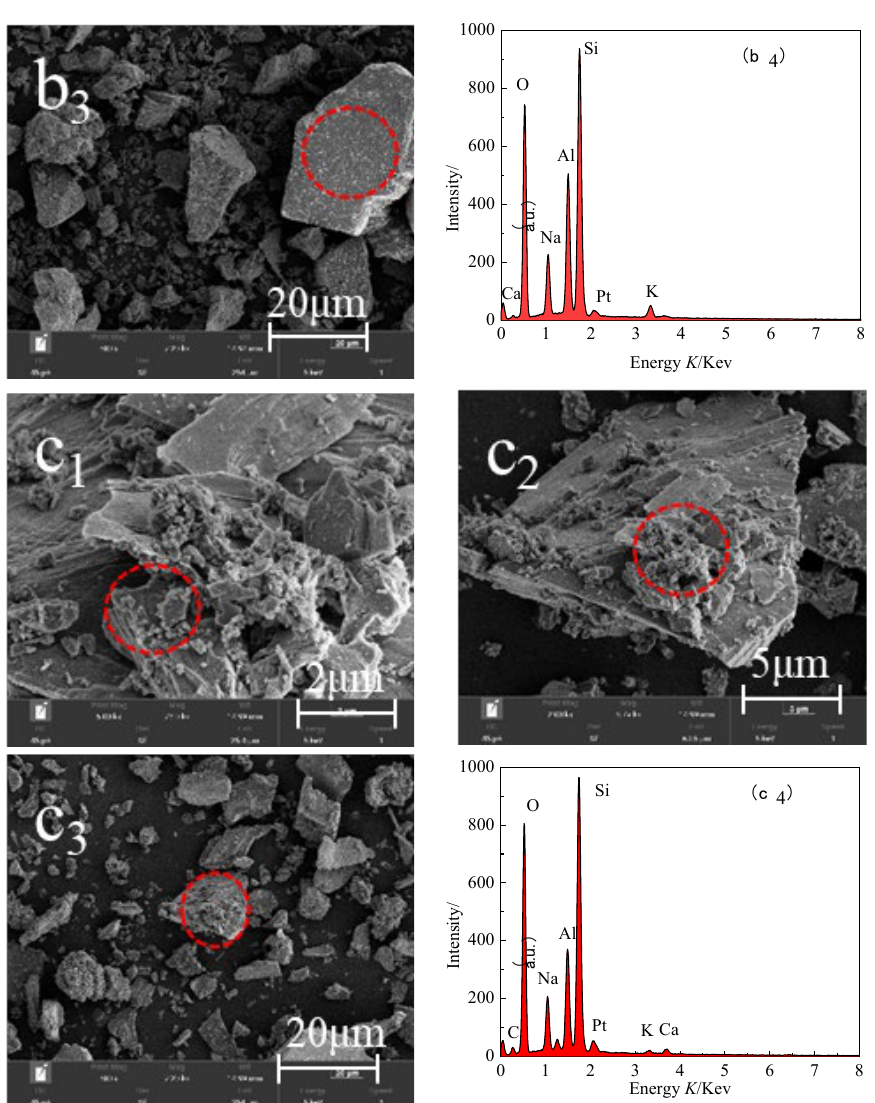
Figure 9. Electron microscope scans and energy spectra of anorthite ( a ), leach residue ( b ) and carbonation products ( c ). (Subfigure 1: 2 μm ruler; Subfigure 2: 5 μm ruler; Subfigure 3: 20 μm ruler.)